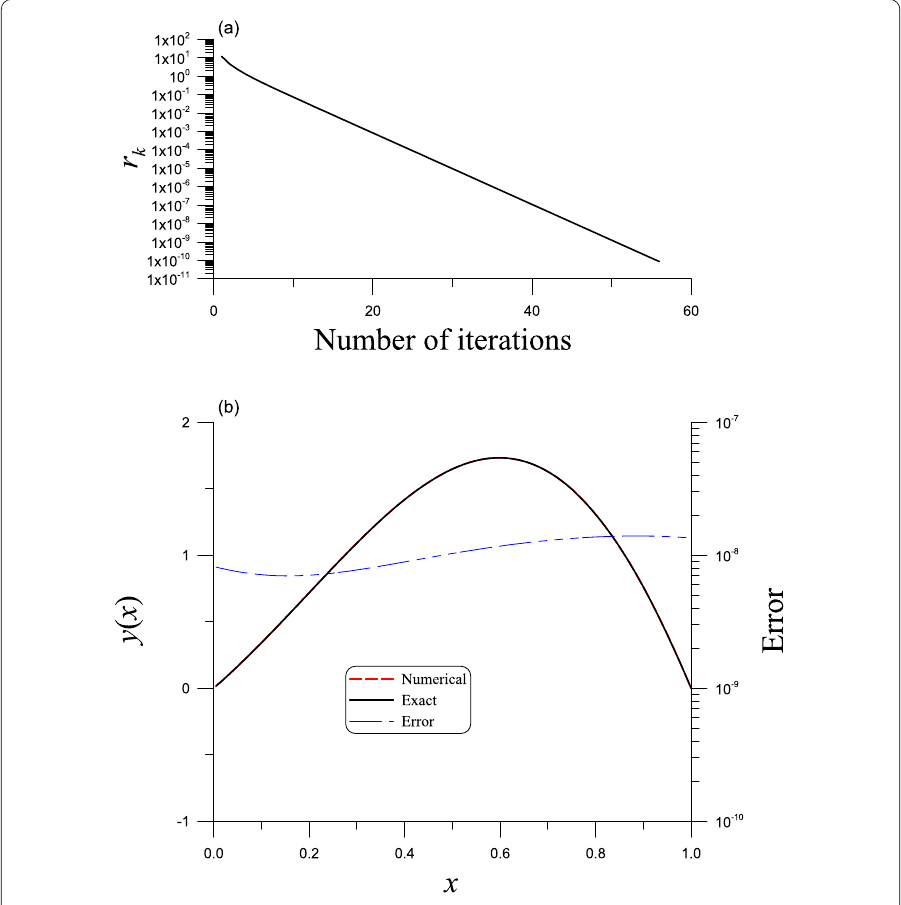
Figure 8 For Example 6 of a non-separated three-point quadratic nonlinear BVP solved by the iterative algorithm BSFM, ( a ) showing convergence behavior and ( b ) comparing numerical and exact solutions and showing numerical error